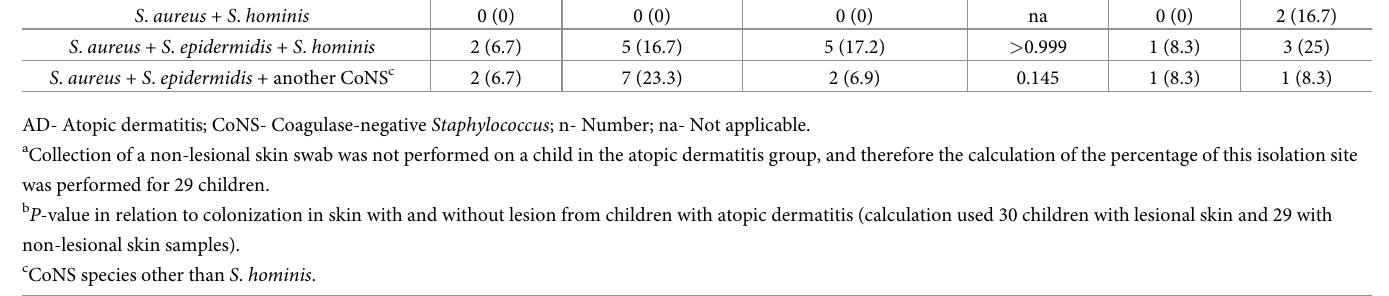
Collection of a non-lesional skin swab was not performed on a child in the atopic dermatitis group, and therefore the calculation of the percentage of this isolation site was performed for 29 children. b P -value in relation to colonization in skin with and without lesion from children with atopic dermatitis (calculation used 30 children with lesional skin and 29 with non-lesional skin samples). c CoNS species other than S . hominis